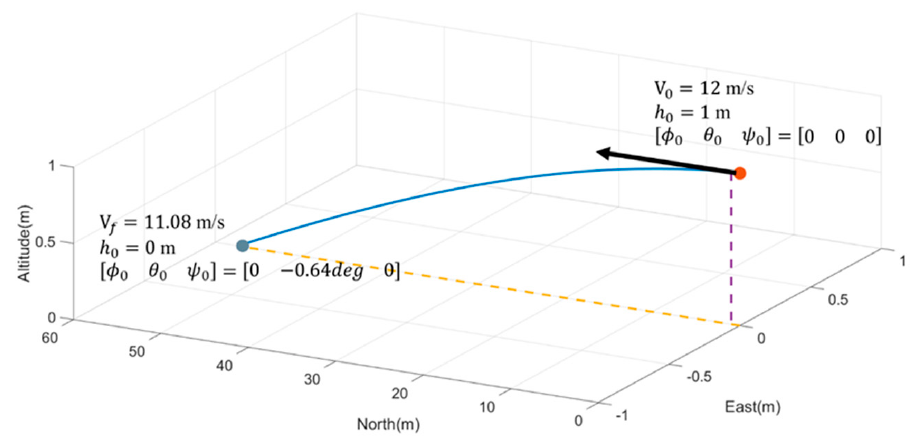
Figure 6. The results for the verification gliding case. From the results, the UAV glides about 50 m northward. The altitude decreases steadily and finally reaches zero. A detailed analysis of the motion and energy is shown in Figure 7.